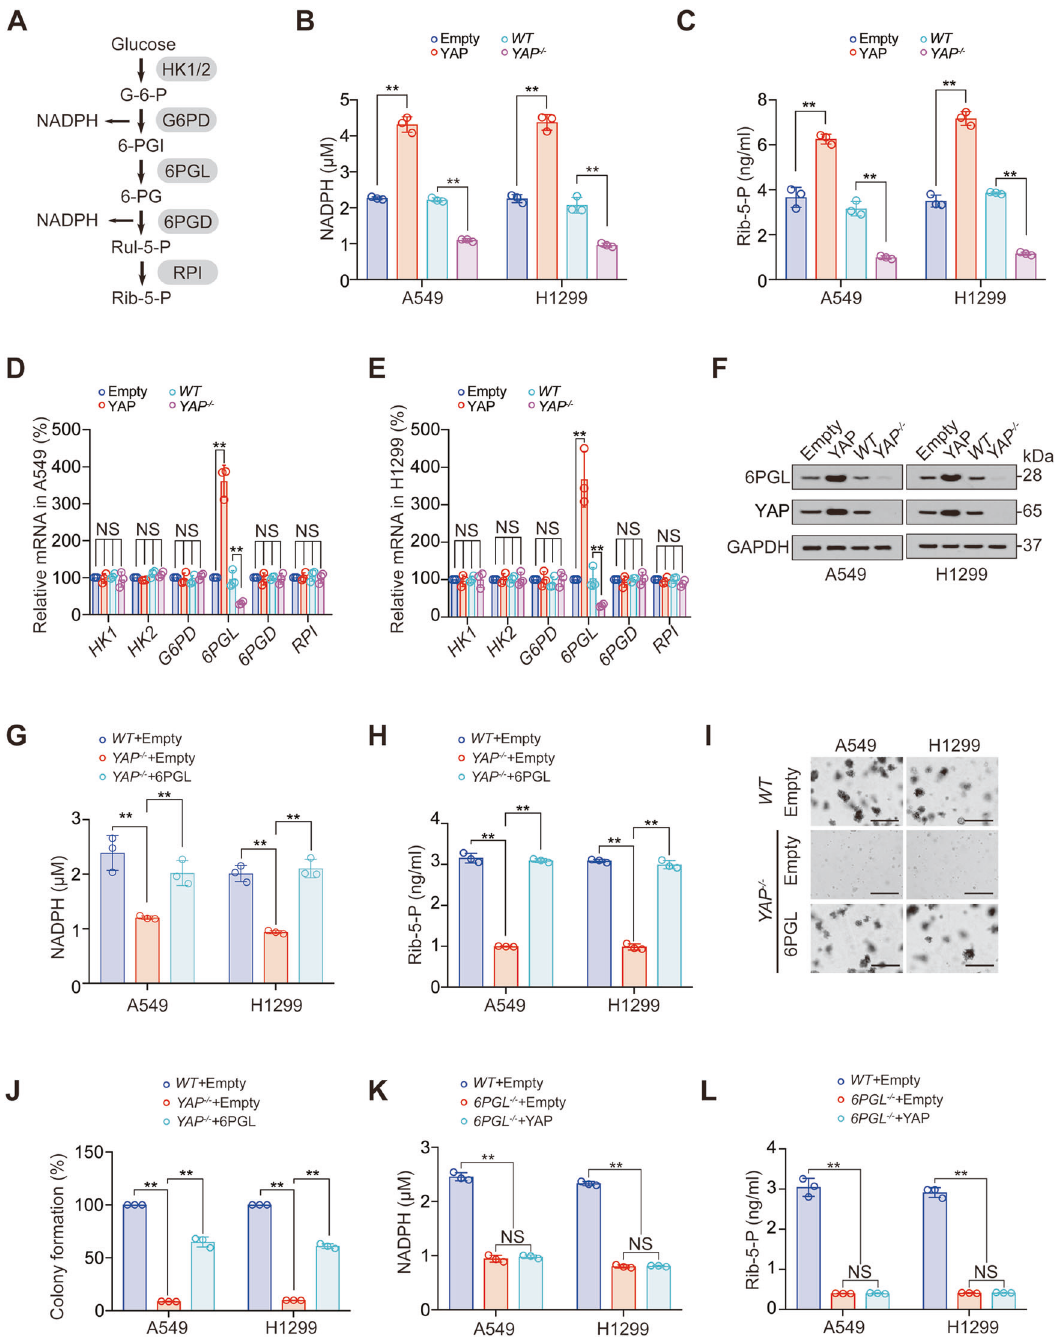
knockout A549 ( D ) and H1299 ( E ) cells. F 6PGL and YAP protein levels in control, YAP overexpression or knockout A549 and H1299 cells. G – J NADPH ( G ), Rib-5-P concentration ( H ), and colony formation ( I , J ) were measured in WT or YAP − / − A549 and H1299 cells with or without 6PGL overexpression. Scale bar, 200 μ m. K , L NADPH (K) and Rib-5-P concentration ( L ) were measured in WT or 6PGL − / − A549 and H1299 cells with or without YAP overexpression. The data are shown as the mean ± SD from three biological replicates (including IB). Data in B – E , G – I , K , L were analyzed using a one-way ANOVA test. ** P < 0.01, NS nonsigni fi